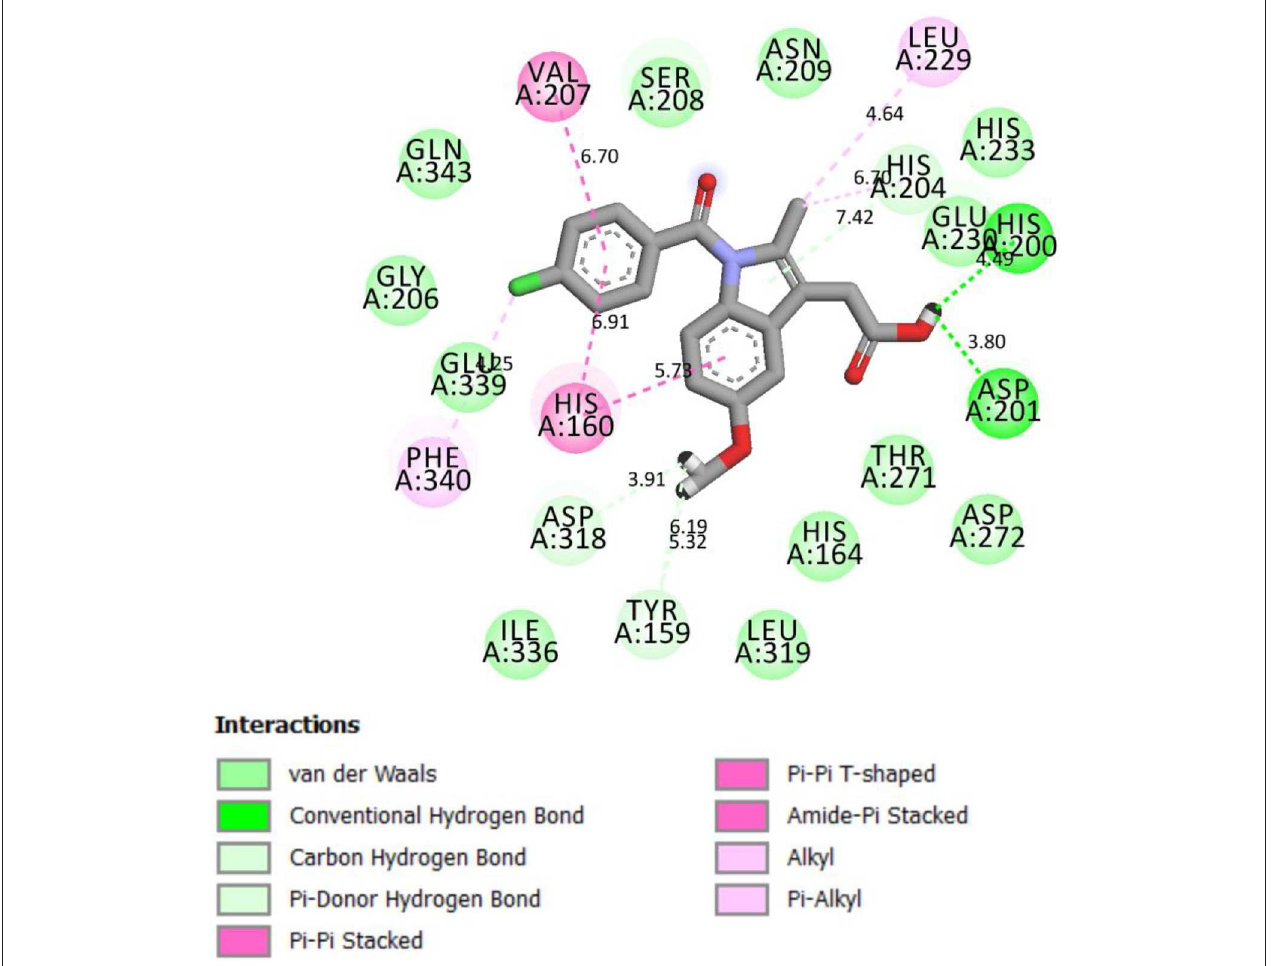
FIGURE 4 | 2D representation of binding interaction of indomethacin and the amino acid residues of 4WCU.